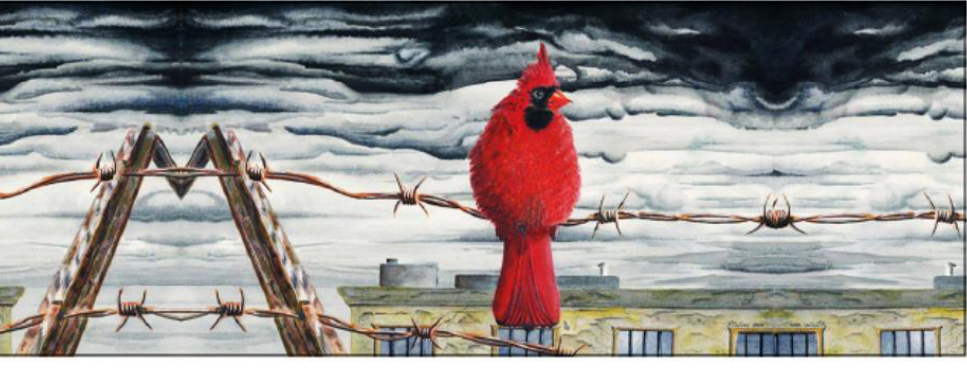
Figure 5: Drawing by PC (2015: